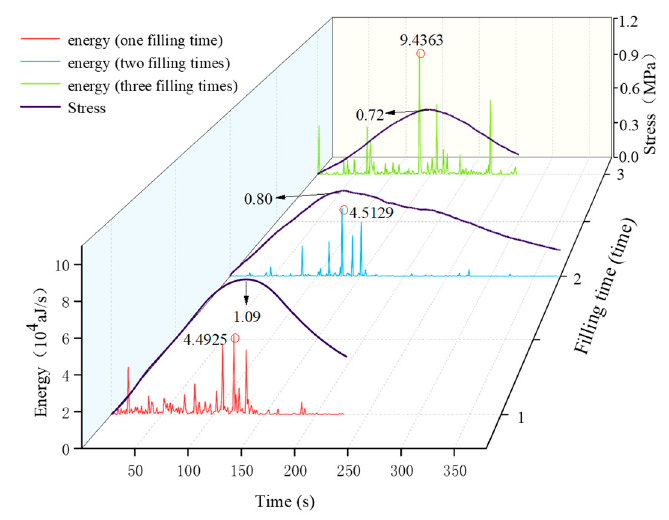
Figure 5. The energy of LCTB with different filling times.